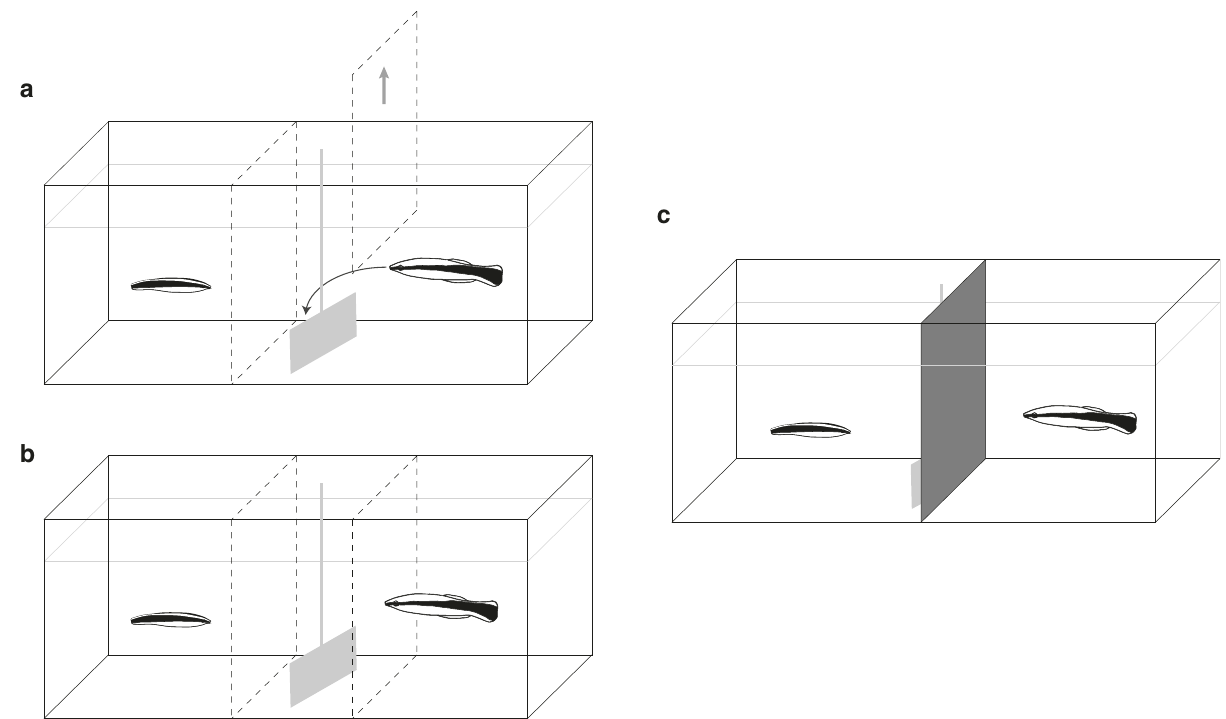
Fig. 1 Experimental setup of experiments 1 and 2. During the demonstration phase ( a , b ), the cleaners were separated via a clear partition (juvenile depicted on the left side, and as smaller compared to the adult). In each trial, a plate with food facing the juvenile was introduced behind a second clear partition that made it inaccessible for the adult. a In the observer treatments, the clear partition between the demonstrator and the plate was removed, and the demonstrator was allowed to interact with the plate. b In the control treatments, the plate remained con fi ned and no interaction could occur. c During individual testing, an opaque barrier separated the young and adult cleaners. The juveniles were initially con fi ned and could then approach the plates presented. The plates would follow the same response rules they exhibited during